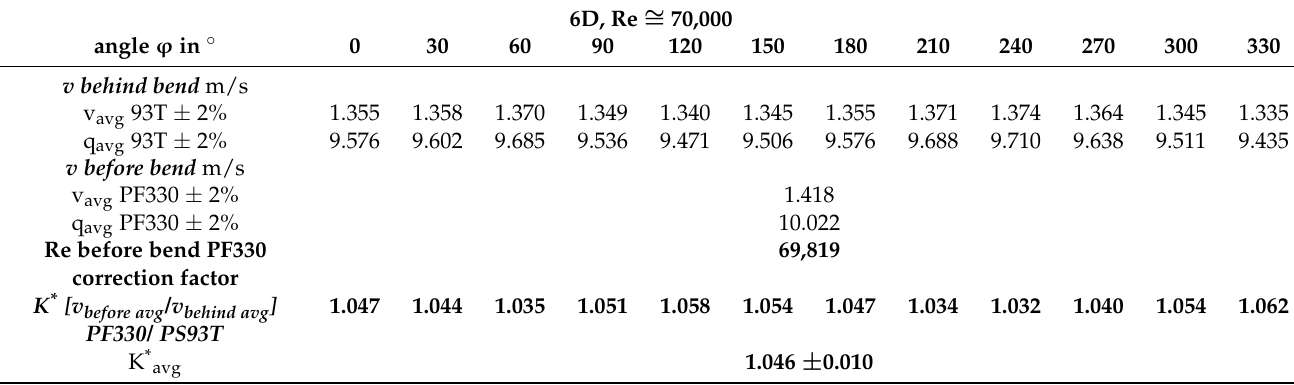
Table 5. Summary of the results of ultrasonic measurements for the 6D plane from the disturbing element as a function of the mounting angle of the ultrasonic flow meter sensors, Re ∼ = 70,000. 6D, Re ∼ = 70,000 angle ϕ in ◦